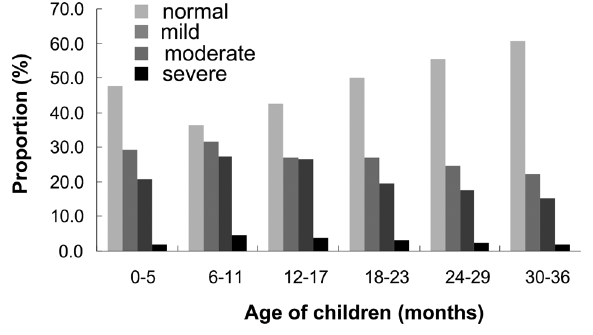
Figure 1. Severity of anemia in six age groups among children under 36 months in rural western China.